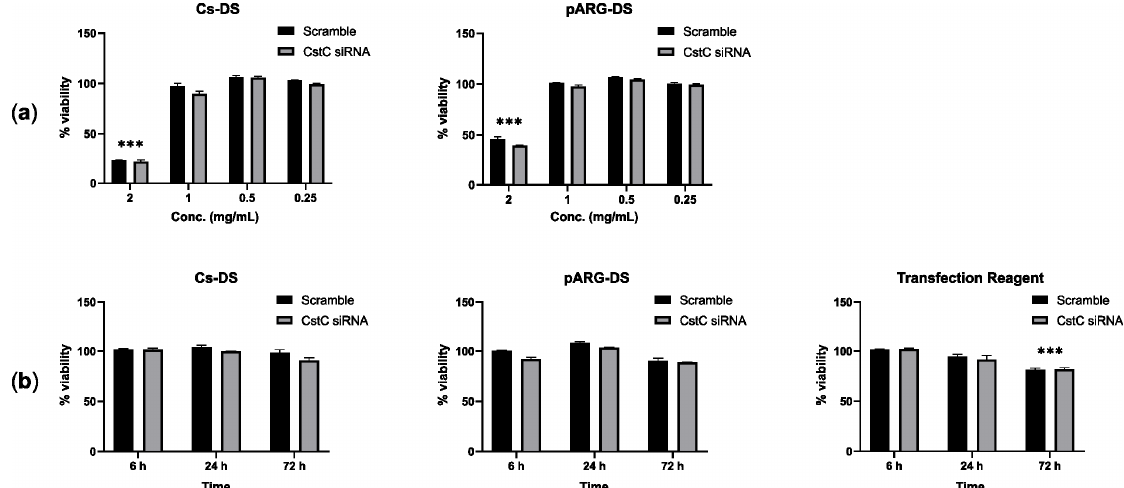
Figure 1. Effect of Cs and pARG particles on the viability of human monocyte-derived macrophages: ( a ) Macrophages were treated with different concentrations of DSs for 72 h or ( b ) treated with 1 mg/mL of DSs for different periods. The tested DSs were loaded with anti-CstC siRNA or scramble control siRNA. A transfection reagent (ScreenfectA) was used for comparison. Macrophage viability was measured using PrestoBlue (resazurin-based solution) by quantifying the fluorescence emission in a plate reader. Results were calculated relative to untreated macrophages (100% viability) and 0.05 % Igepal-treated macrophages (0% viability). Bars represent the average of three independent experiments, and the error bars depict the standard error of the mean. *** p ≤ 0.001 is relative to the control and all other concentrations tested ( a ) or to all other treatment times ( b ).